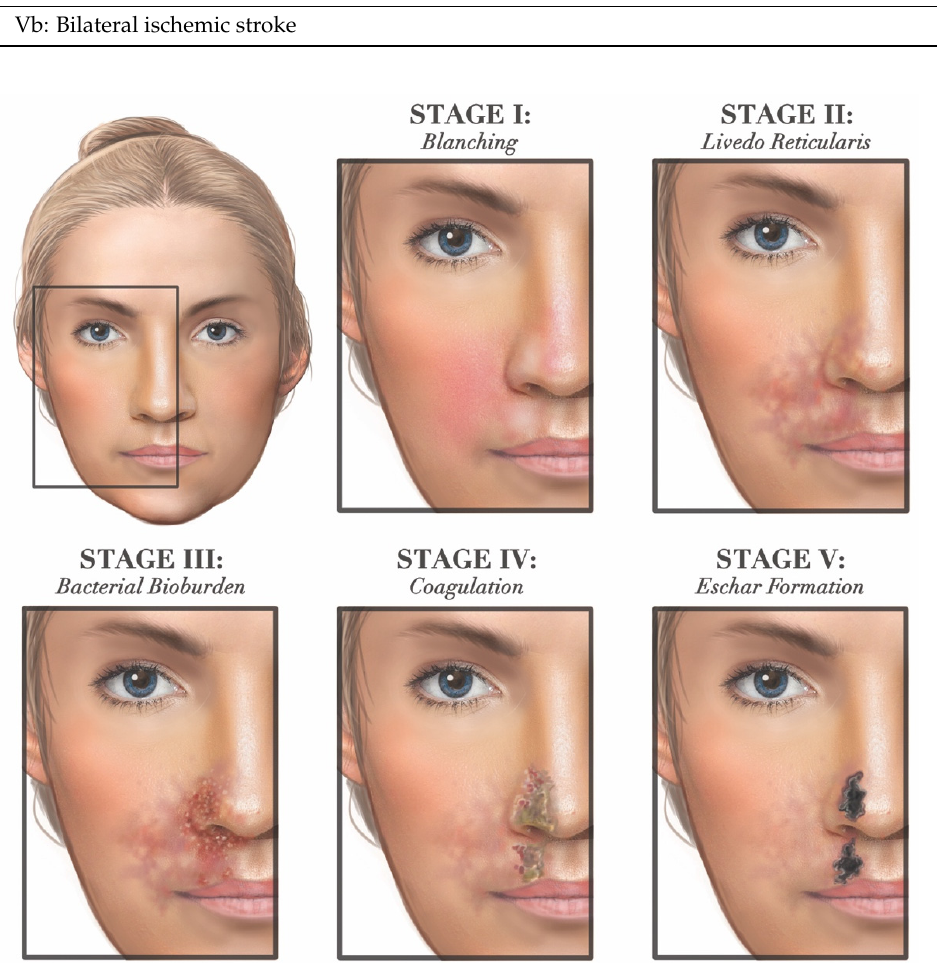
Figure 18. The clinical stages and appearance of the skin following an ischemic injury caused by vascular occlusion with dermal fillers. Stage I occurs immediately and is characterized by skin blanching with delayed capillary refill. Stage II manifests over 72 h with livedoid skin changes due to dermal pooling of deoxygenated blood in underperfused regions. Stage III is characterized by the functional deterioration of the skin barrier with partial desquamation and overgrowth of cutaneous flora. Stage IV occurs 5–10 days post injury and is characterized by coagulative necrosis with the eventual formation of an eschar (stage V) that may persist for weeks.